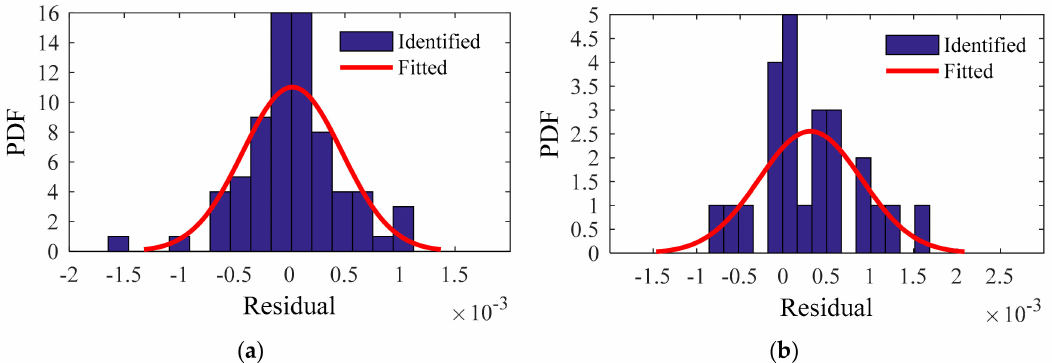
Figure 19. Second modal frequency: identified PDF and fitted PDF of the residual: ( a ) Training sample; ( b ) Testing sample.